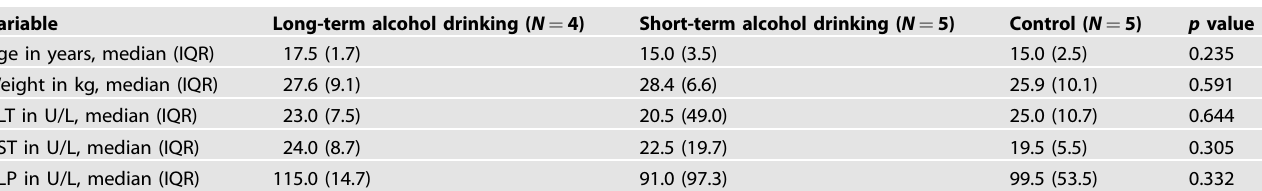
Table 2. Baboons ’ main demographic and biochemical